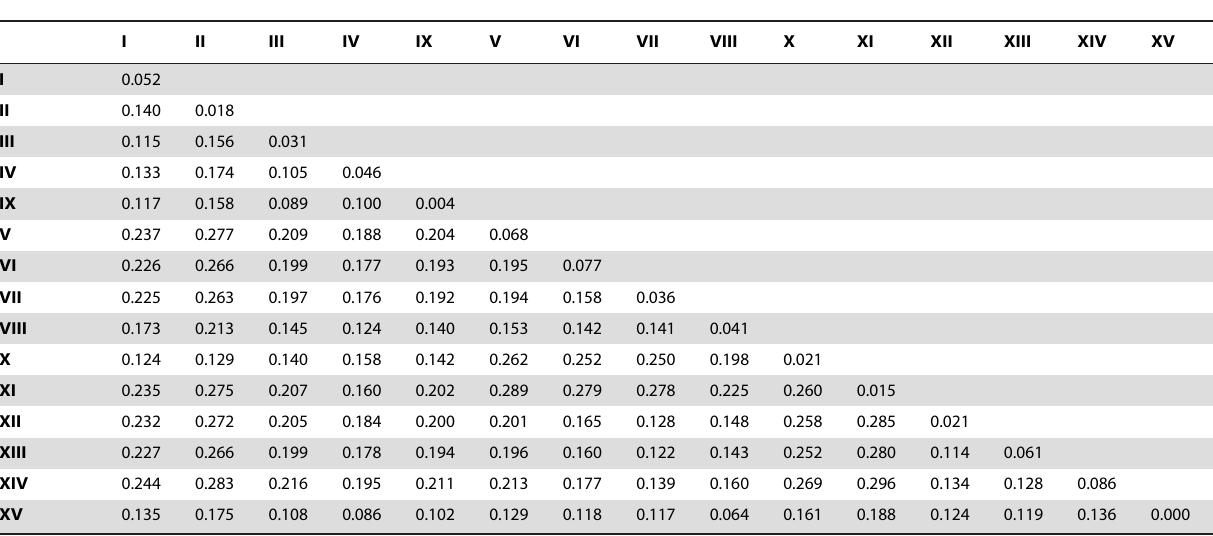
Table 3. Estimates of evolutionary distances between